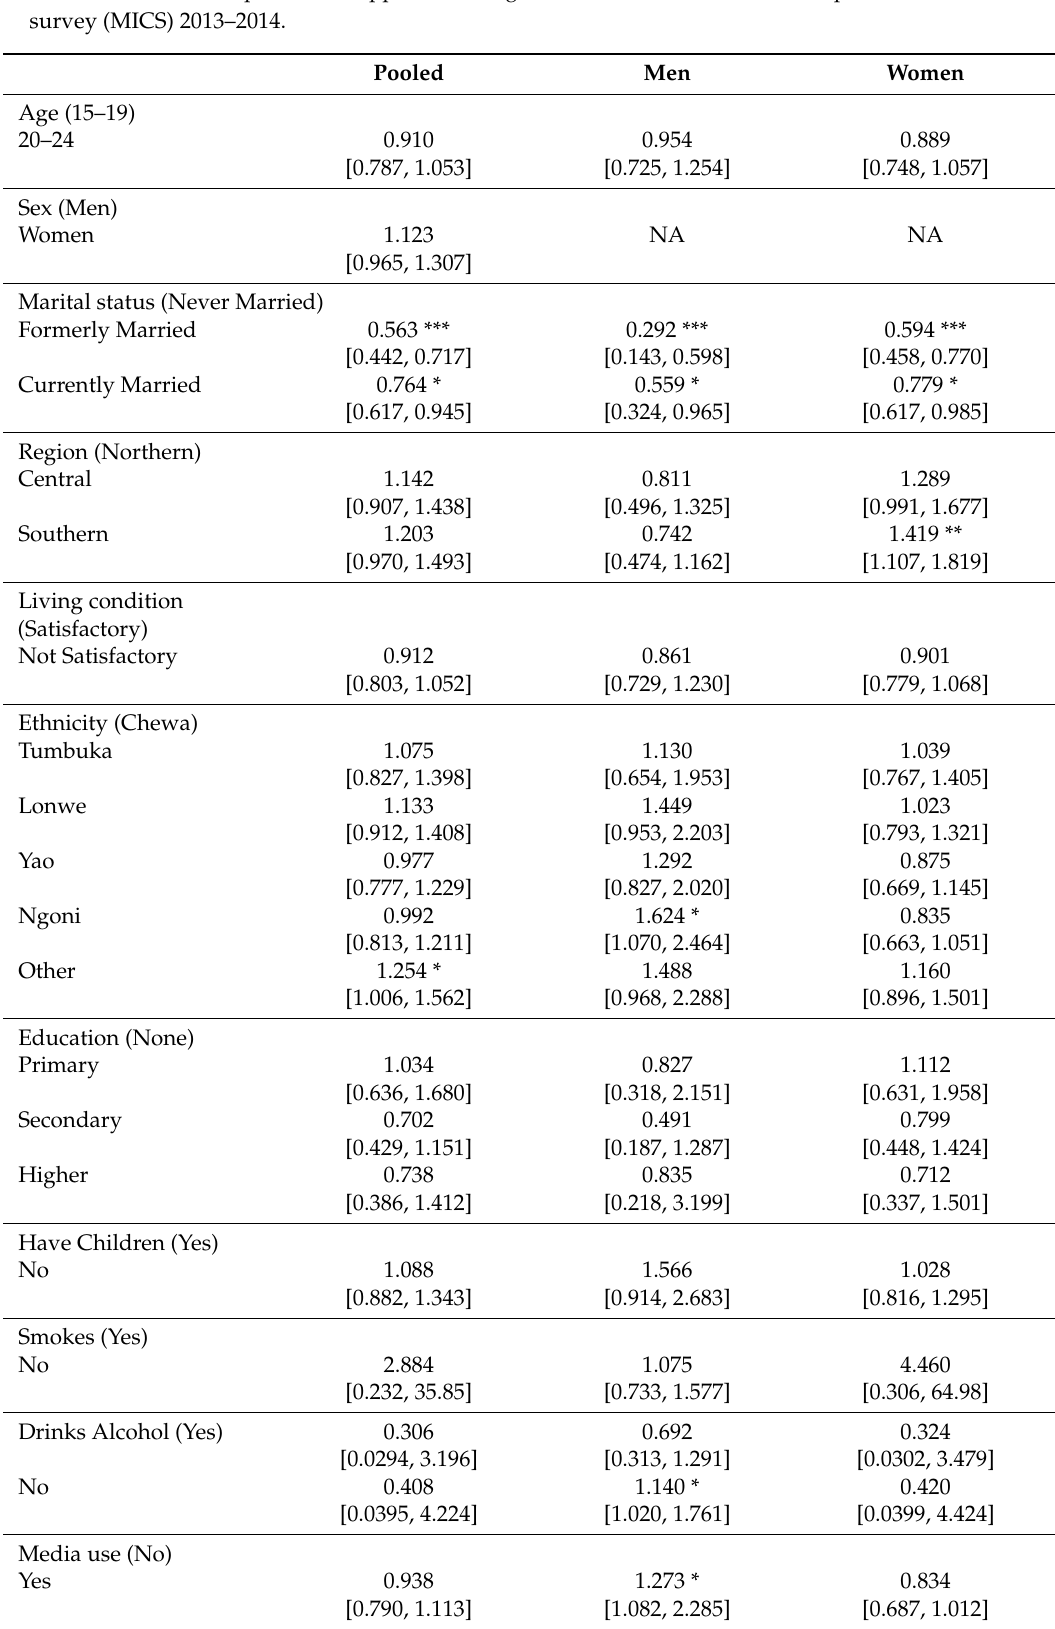
Figure represent odd ratios; 95% confidence intervals in brackets. * p < 0.05, ** p < 0.01, *** p <